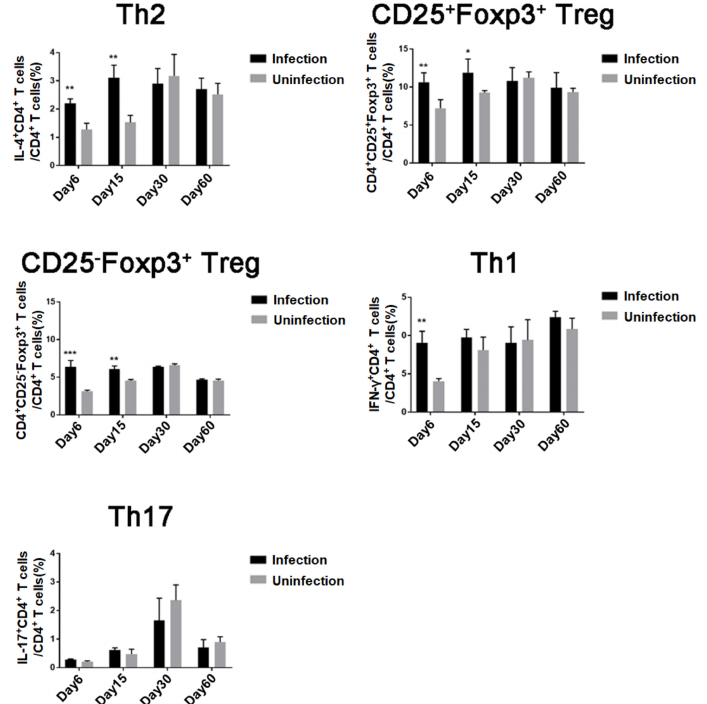
Figure 1. Differentiation of Treg, Th1, Th2, and Th17 cells in mice during T. spiralis infection: For each of three independent experiments, 16 female BALB / c mice were each infected with 400 T. spiralis ML. Four mice were randomly sacrificed at different stages post-infection (intestinal phase, day 6; newborn larva (NBL) migration, day 15; larva capsule, day 30; and convalescent phase, day 60); Th2, Treg, Th1, and Th17 CD4 + T cells in the spleen were measured by fluorescence-activated cell sorting (FACS). Data are shown as means ± SDs; * p < 0.05; ** p < 0.01; *** p <